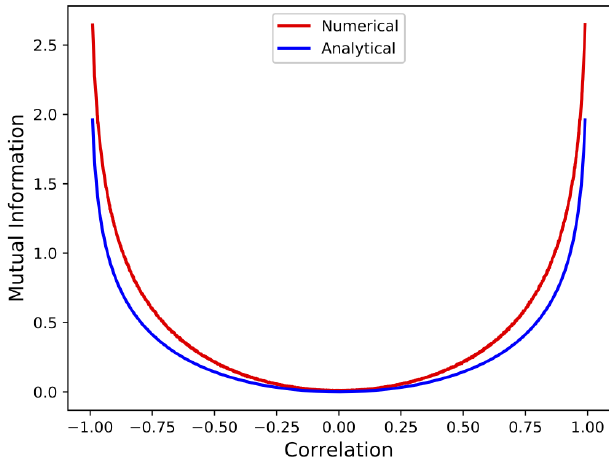
Figure 1. Mutual information estimator for bivariate Gaussian ran- dom variables with σ x = σ y = 1 and zero mean as a function of the correlation ρ ∈ [− 1 , 1 ] . The numerical value is traced in red and the analytical in blue. The estimator is computed for N = 10 5 points and 46 ( (cid:39) N 1 / 3 ) bins according to the Freedman–Diaconis